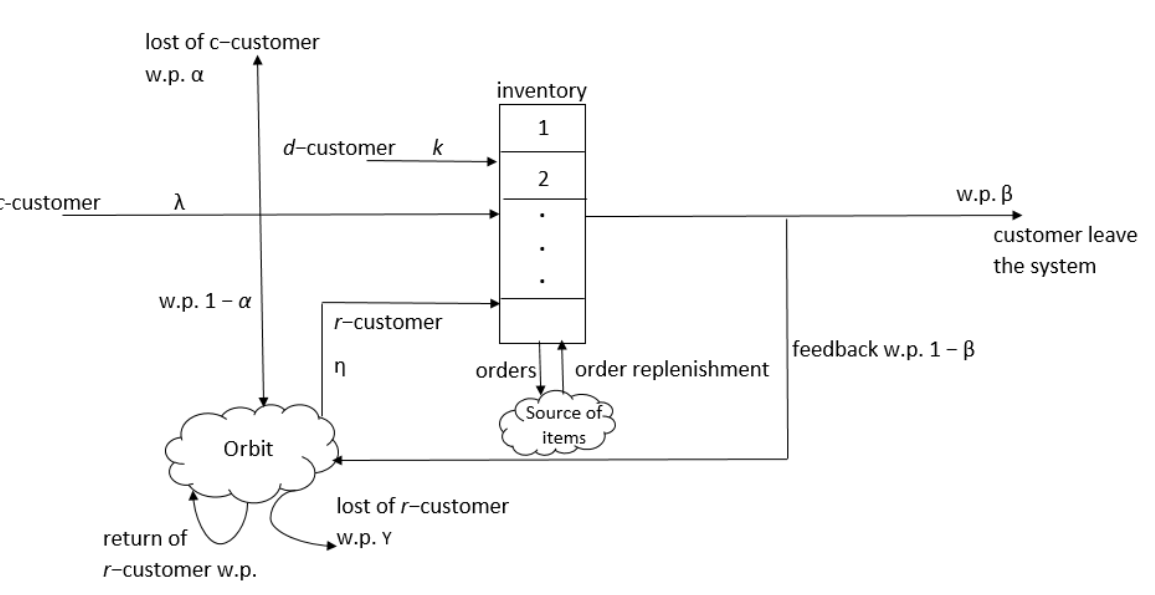
Figure 1. General block diagram of the studied systems.